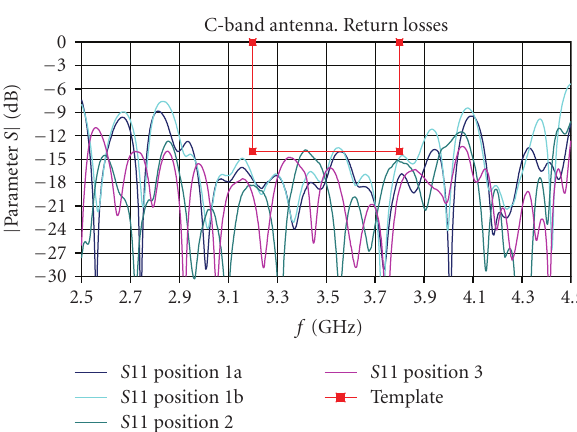
Figure 14: Complete antenna return losses at each pointing position.